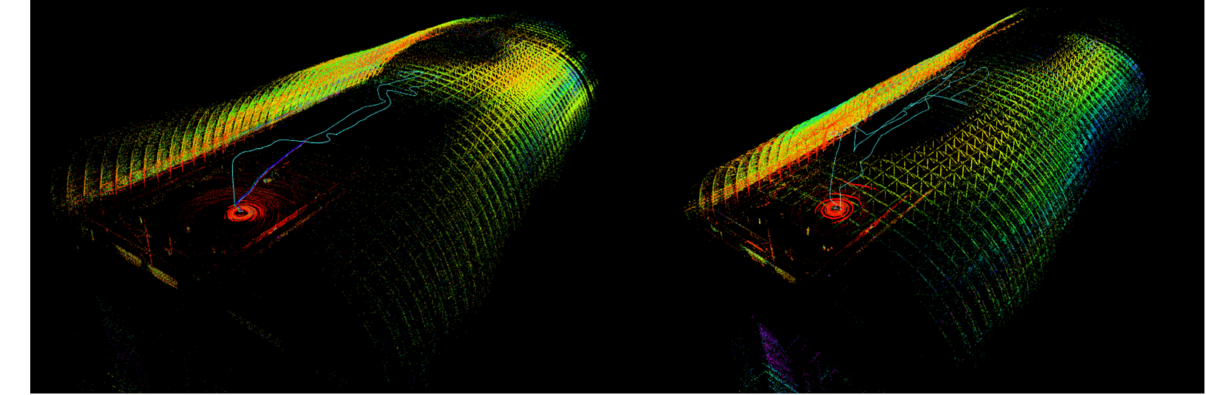
Figure 10. The trajectory of two uninterrupted operations calculated by ArUco_LIO.